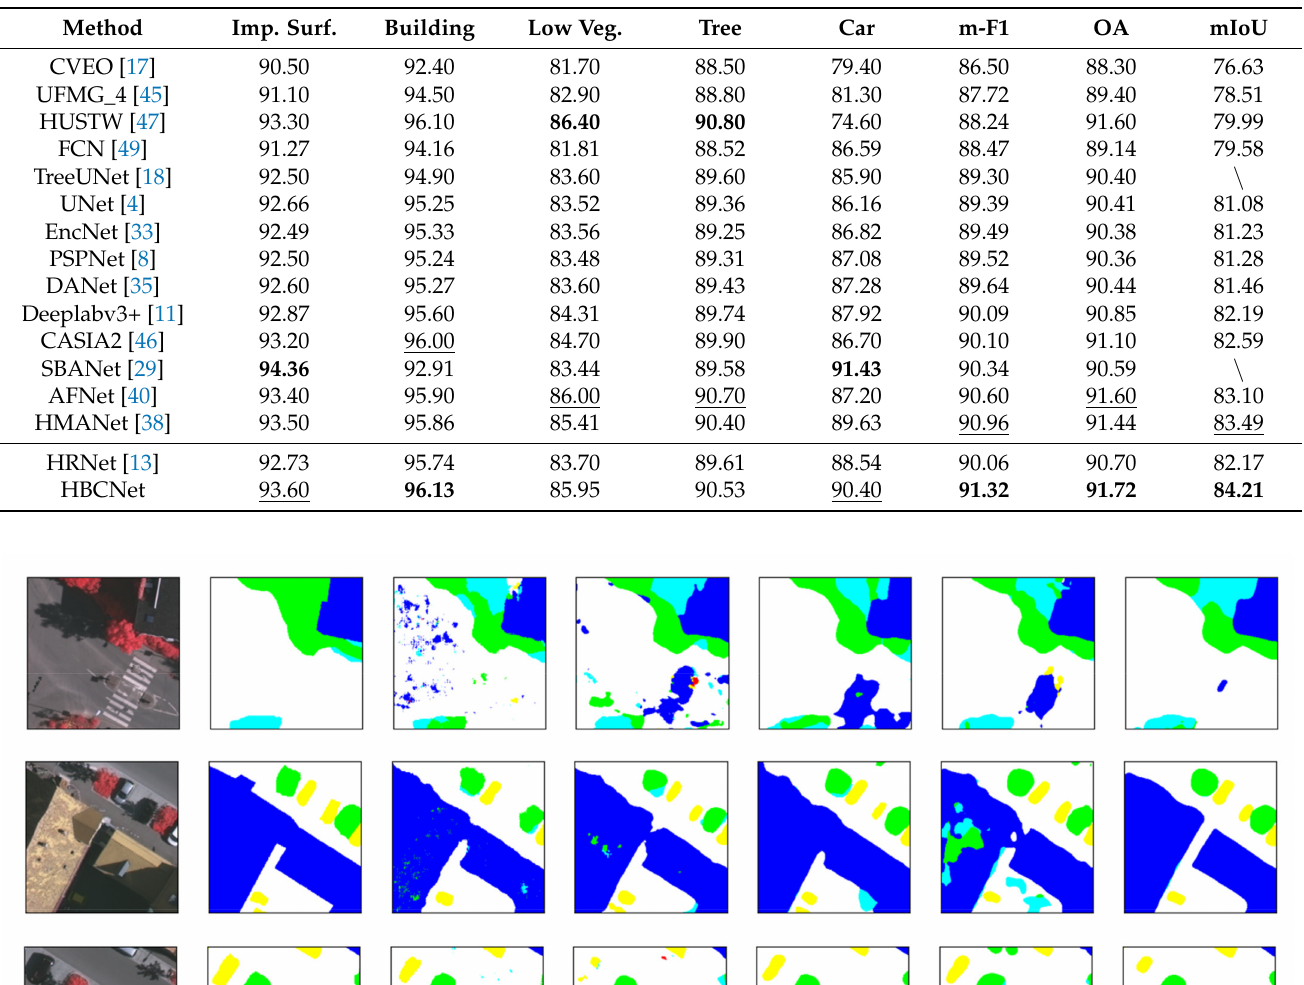
Table 2. Experimental results (%) for the Vahingen dataset. The values in bold are the best and the values underlined are the second best.